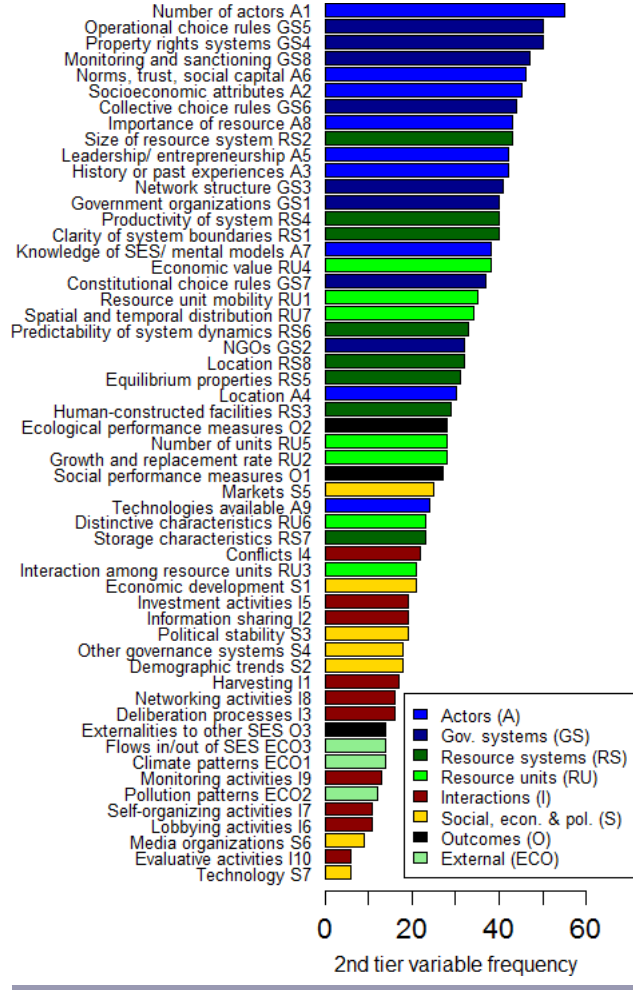
Fig. 2. The frequency of second-tier variables that have been focused on, either conceptually or empirically, across all relevant